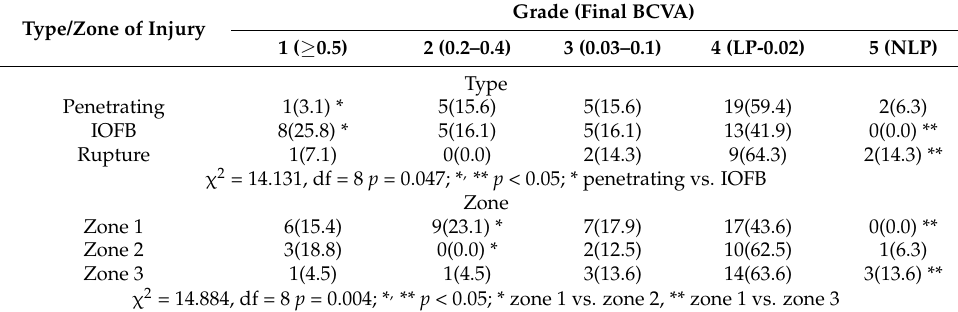
Table 6. Distribution of clinical factors by final best-corrected visual acuity.